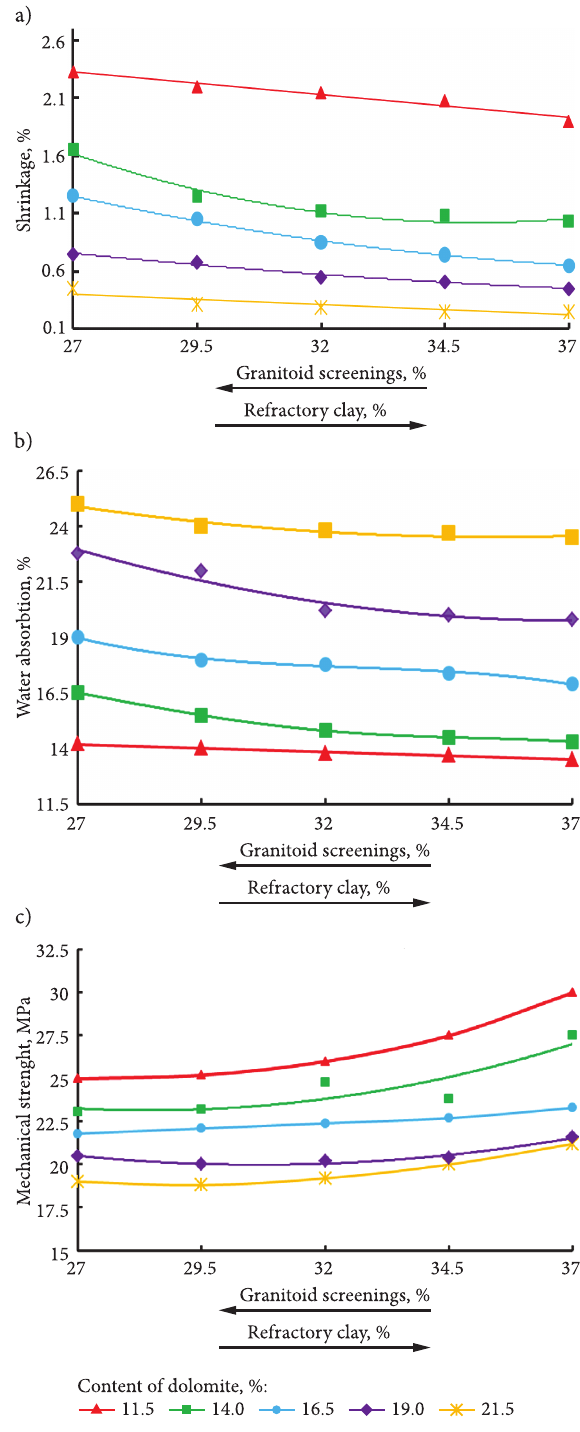
Fig. 2. Dependence of shrinkage (a), water absorption (b), mechanical strength (c) on the composition of ceramic